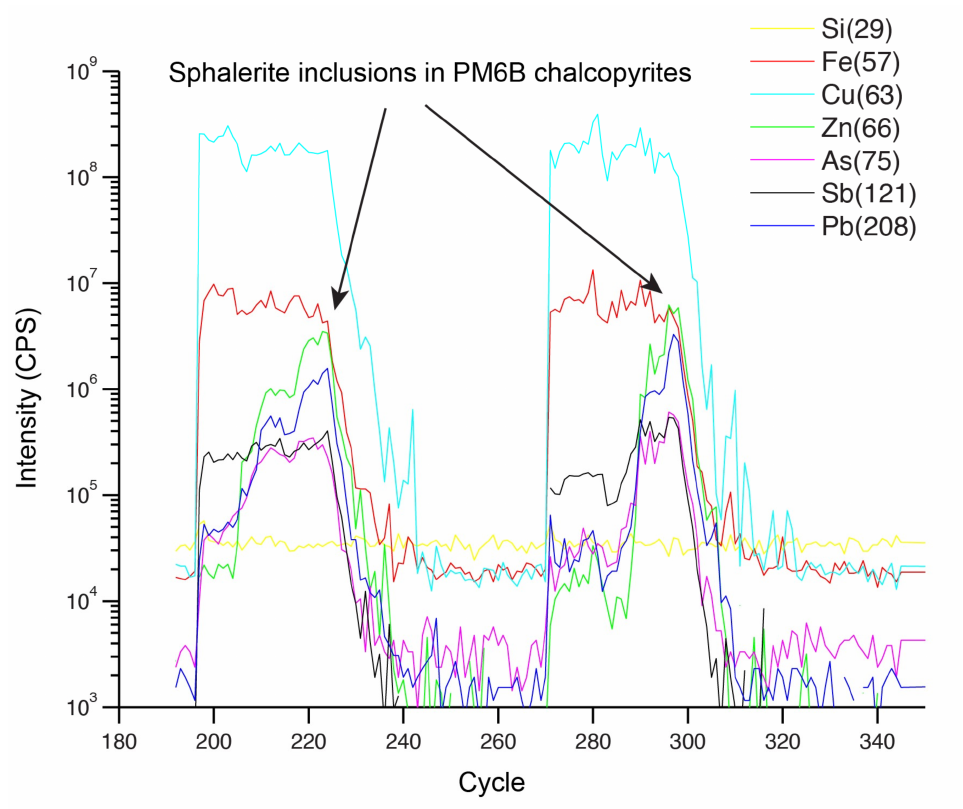
Figure 3. Laser ablation spectra with display of background signal for 7 elements (Si, Fe, Cu, Zn, As, Sb and Pb). Shown here are signal rises of Zn and Pb in chalcopyrite minerals (Sample PM6B)—interpreted as sphalerite inclusions that are rich in Pb (therefore may contain galena as well). Where possible, concentrations from laser spots were calculated from the flattest parts of the ablation spectra, with inclusion-signal